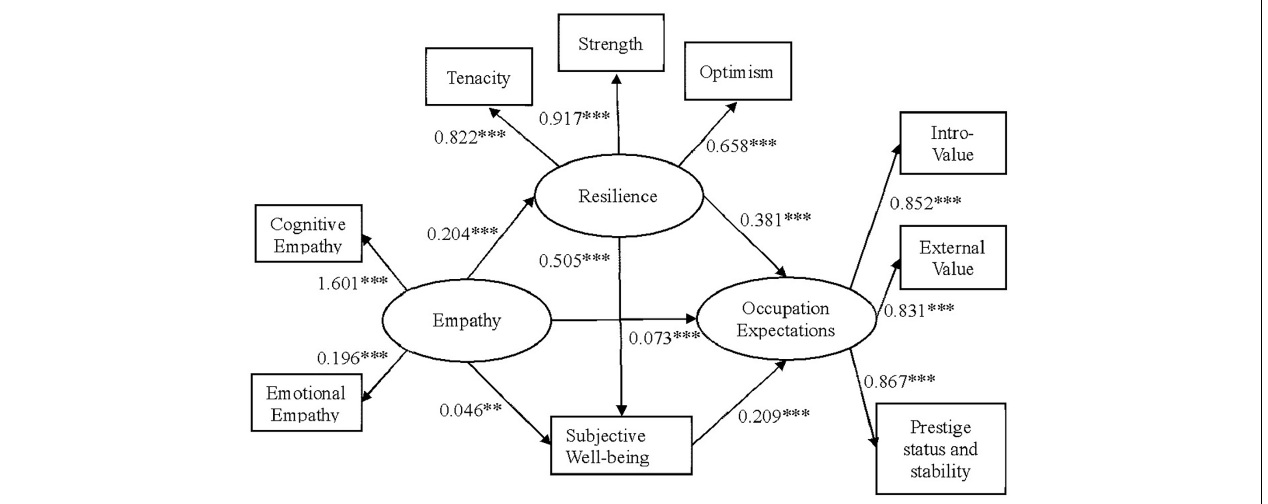
FIGURE 2 | Multiple mediation model. Path values are the path coefficients. ∗∗∗ Correlation is significant at the 0.001 level (two-tailed), ∗∗ correlation is significant at the 0.01 level